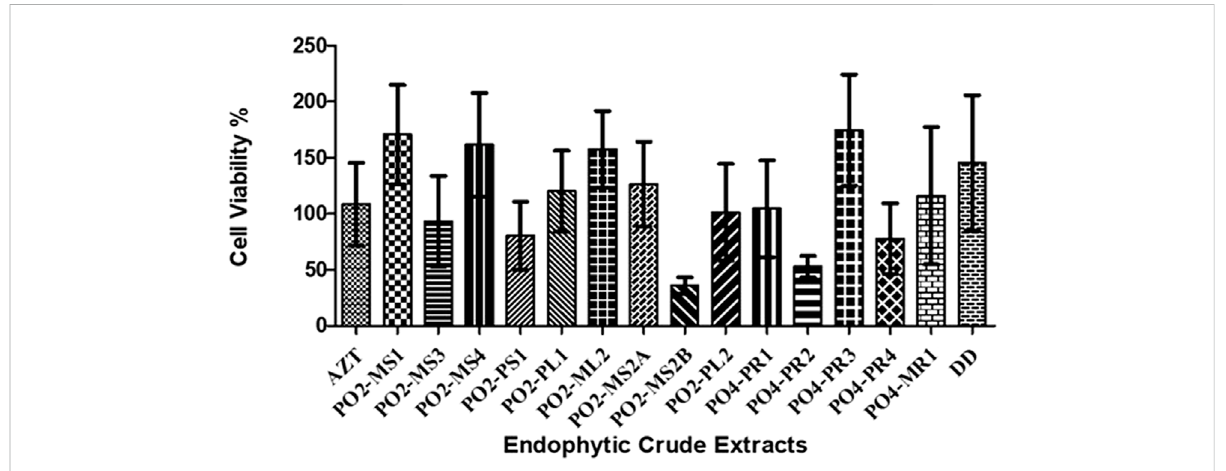
FIGURE 2 Percentage of cell viability of TZM-bI cell lines against eudophytic fungi crude extracts. The endophytic fungi was isolated from the roots, bark and stem of the S. birrea , and Hypoxis species. All the crude extract were not toxic to the cell. Results were obtained from three independent experiments: data are mean